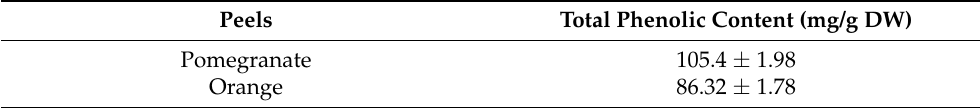
Table 3. Total phenolic content (mg/g DW) in pomegranate and orange peels extracted by methanol.